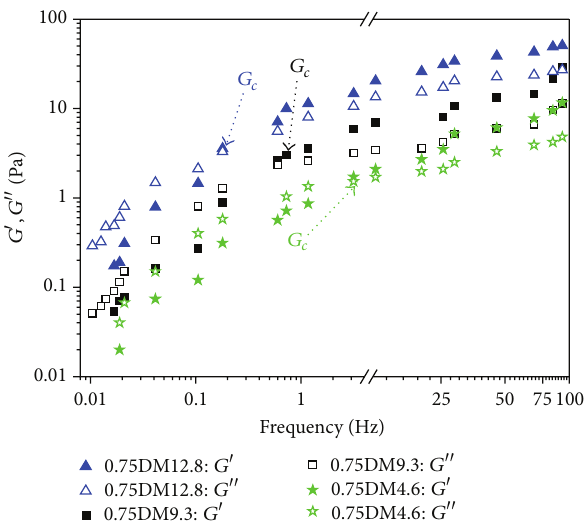
Figure 10: Storage ( 𝐺 󸀠 ) and loss ( 𝐺 󸀠󸀠 ) modulus as a function of frequency for copolymers 0.75DM12.8, 0.75DM9.3, and 0.75DM4.6 and for PAM ( 𝑐 𝑝 = 2.0 gdL −1 , 𝑇 = 25 ∘